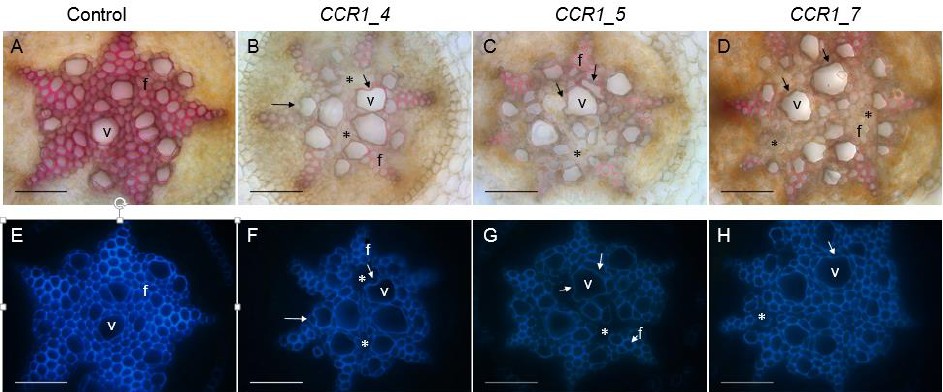
Figure 3. Comparison of xylem development and lignification of xylem cells between control and CCR1 edited lines’ roots. Transversal root sections made at around 10 cm from the root apex of control ( A , E ) and edited lines ( B – D , F – H ). Lignified cell walls are visualized in red/purple by phloroglucinol-HCl ( A – D ) and in blue by UV auto fluorescence ( E – H ). Collapsed vessels in CCR1- edited lines are indicated by arrows. Cells with greatly decreased lignification (non-phloroglucinol staining and / or no auto fluorescence under UV light) are indicated by *. V, vessels; f, fibers. Scale bar = 50 µm .